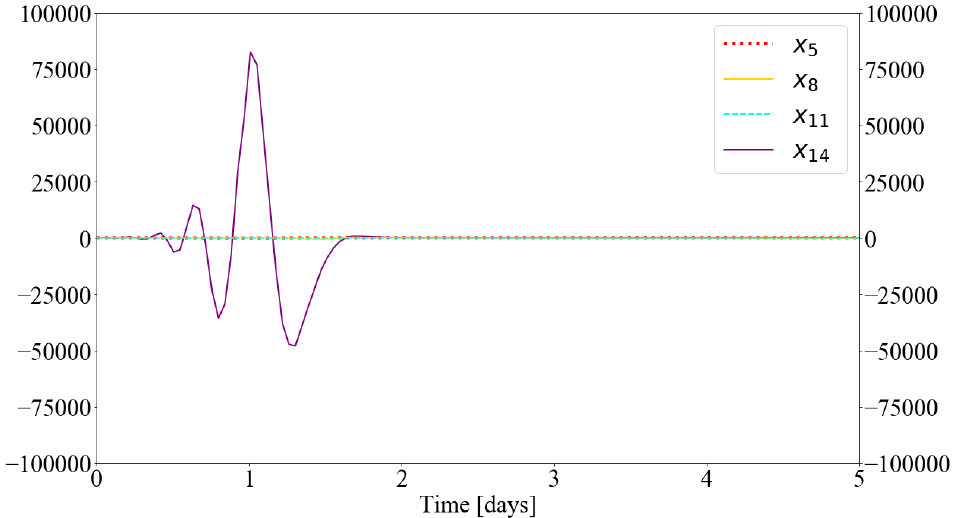
Figure 9. Sensitivity functions x 5 , x 8 , x 11 , and x 14 are the sensitivities x 2 with respect to λ 1 , λ 2 , λ 3 , and λ 4 in time, respectively. The simulation was computed for the initial state x 1 = 0.03047. The solution is more sensitive to variations in the parameters λ and x 3 0 λ 4 = zc 0 than to variations in the parameters λ 1 = ρ m and λ 3 = µ m . We performed the simulation and plotting in Octave 5.1.0.0 and Python 3.7.1,